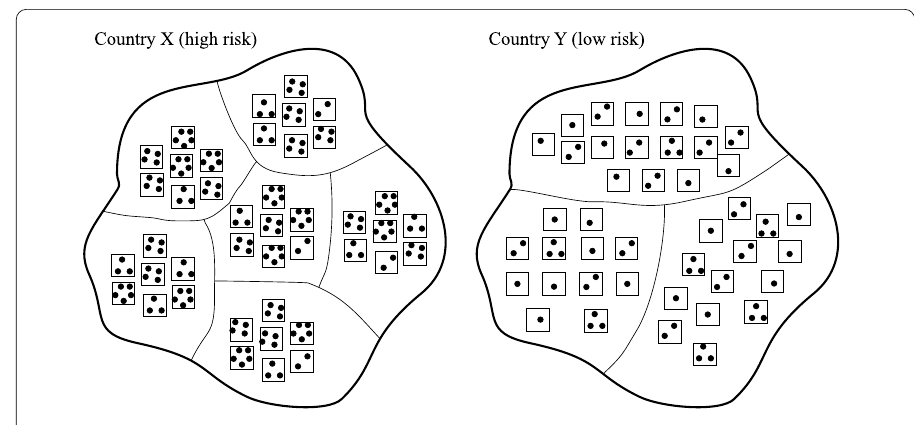
Figure 8 Two dummy countries of equivalent number of entire households, with different household structures and associated risk. Different localizations are bordered by thin lines; rectangles and small dots encode households and their members,